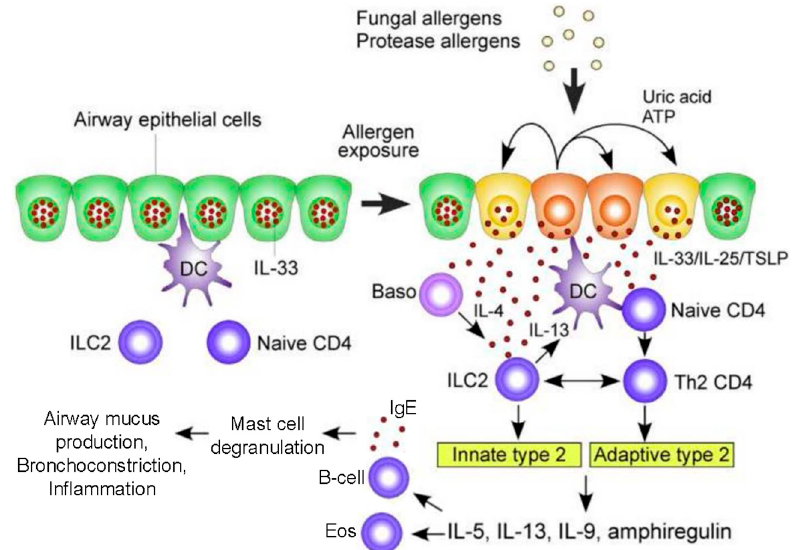
Figure 1. A hypothetical working model to describe the roles of molecular and cellular elements